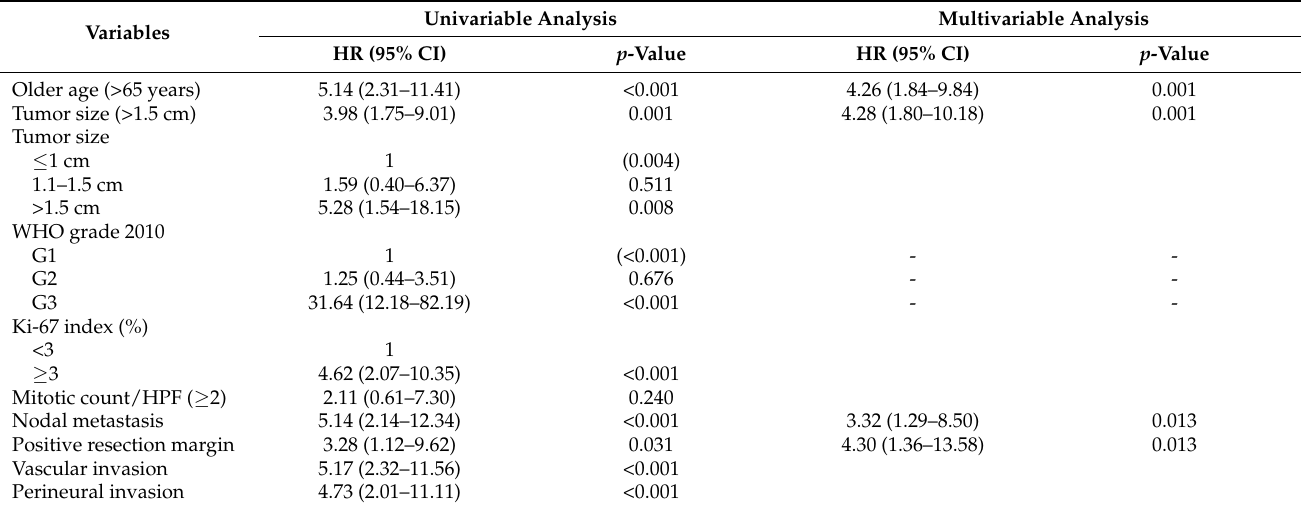
Table 2. Risk factor analysis for overall